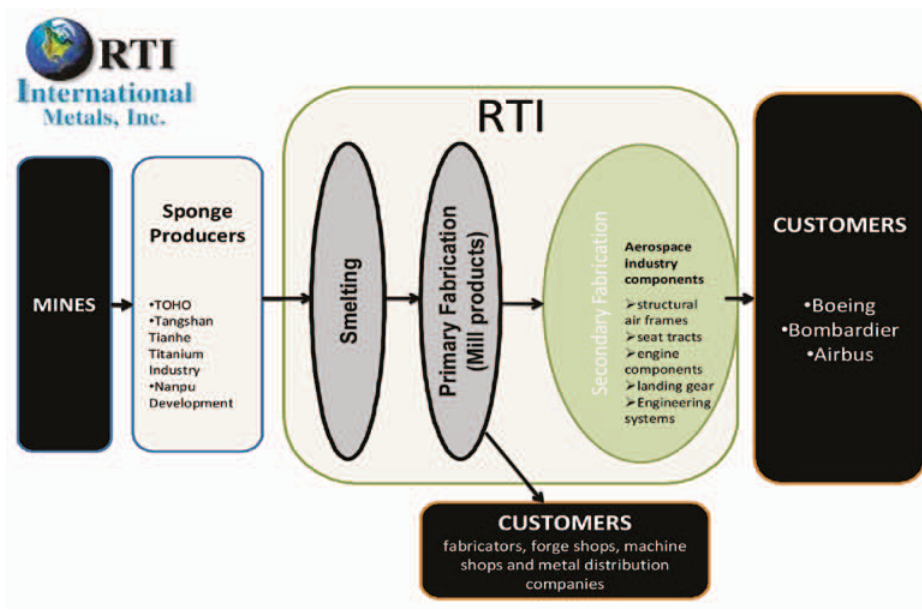
Figure 4: RTI’s supply